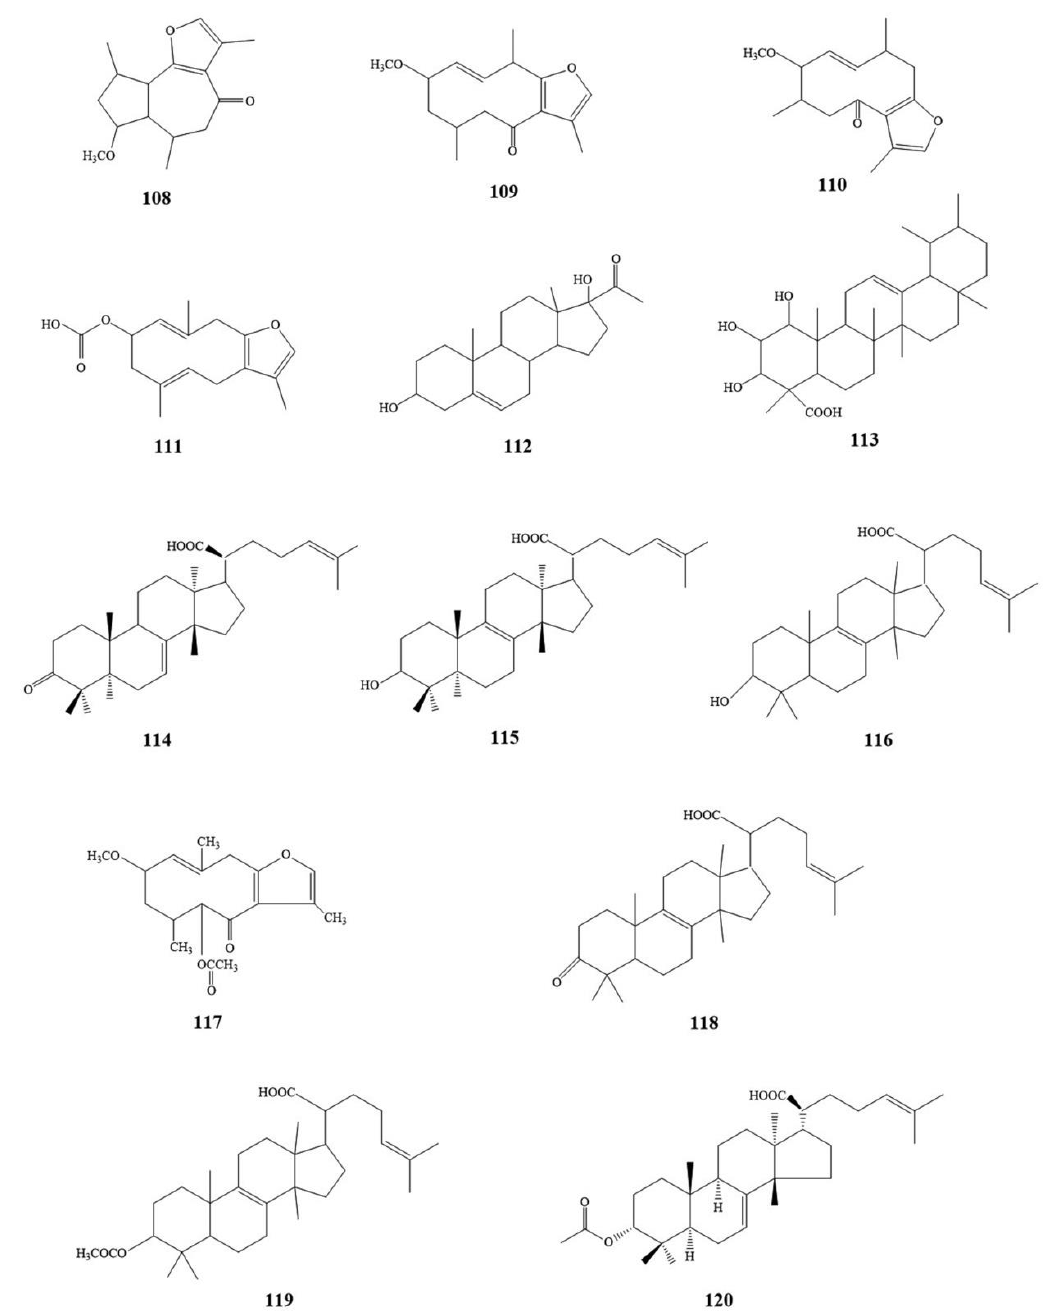
Figure 4. The chemical structure of some potential bioactive components in frankincense – myrrh